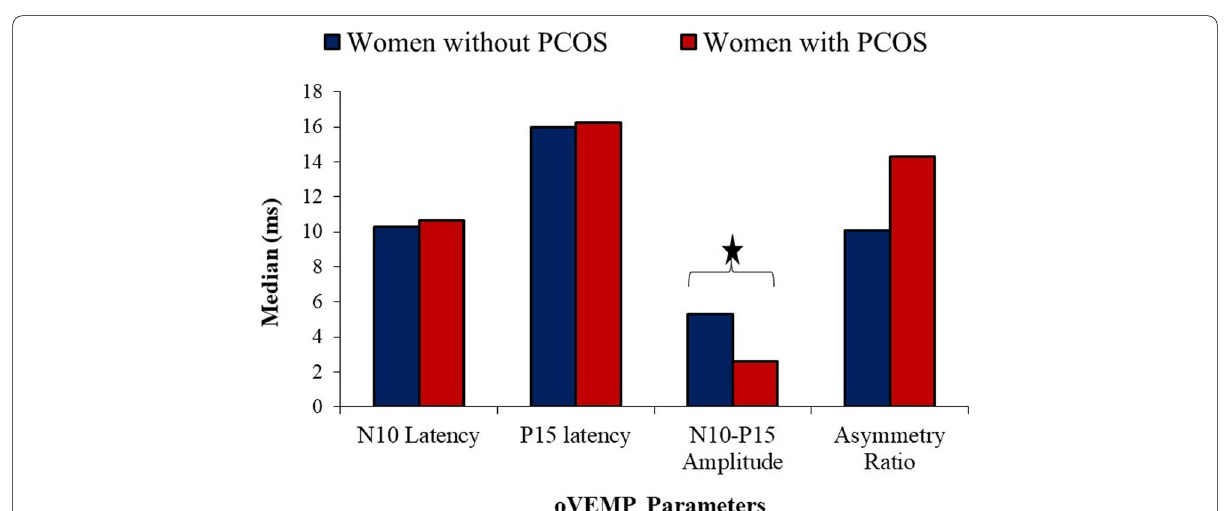
Fig. 5 The median value of the N10, P15 latency, N10-P15 pk-pk amplitude, and asymmetry ratio obtained from women with and without